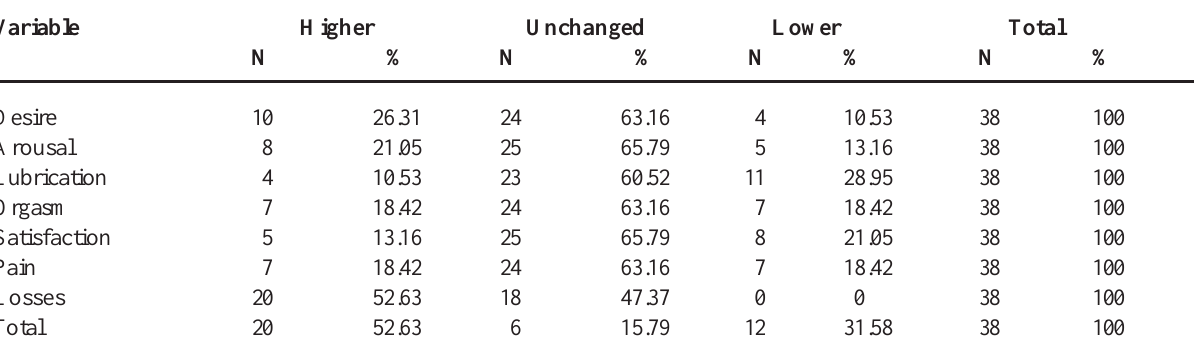
Table 4 – Change in scores for the different questions from before surgery to after surgery. Variable